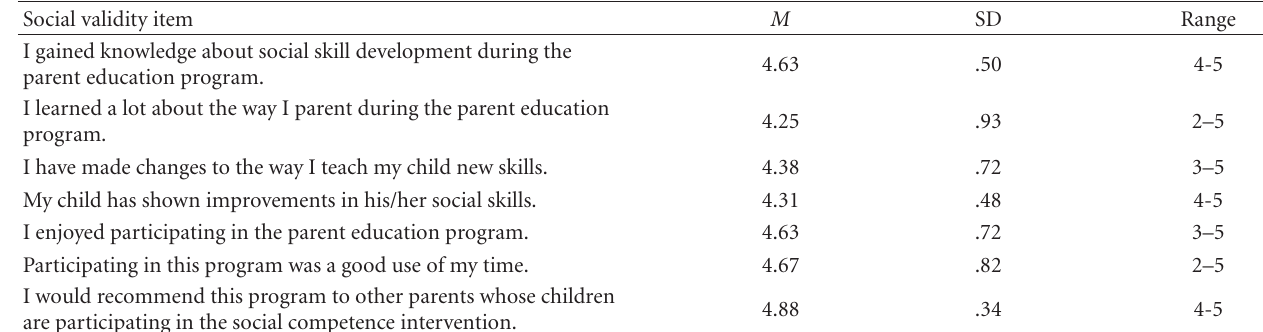
Table 3: SCI-P program social validity